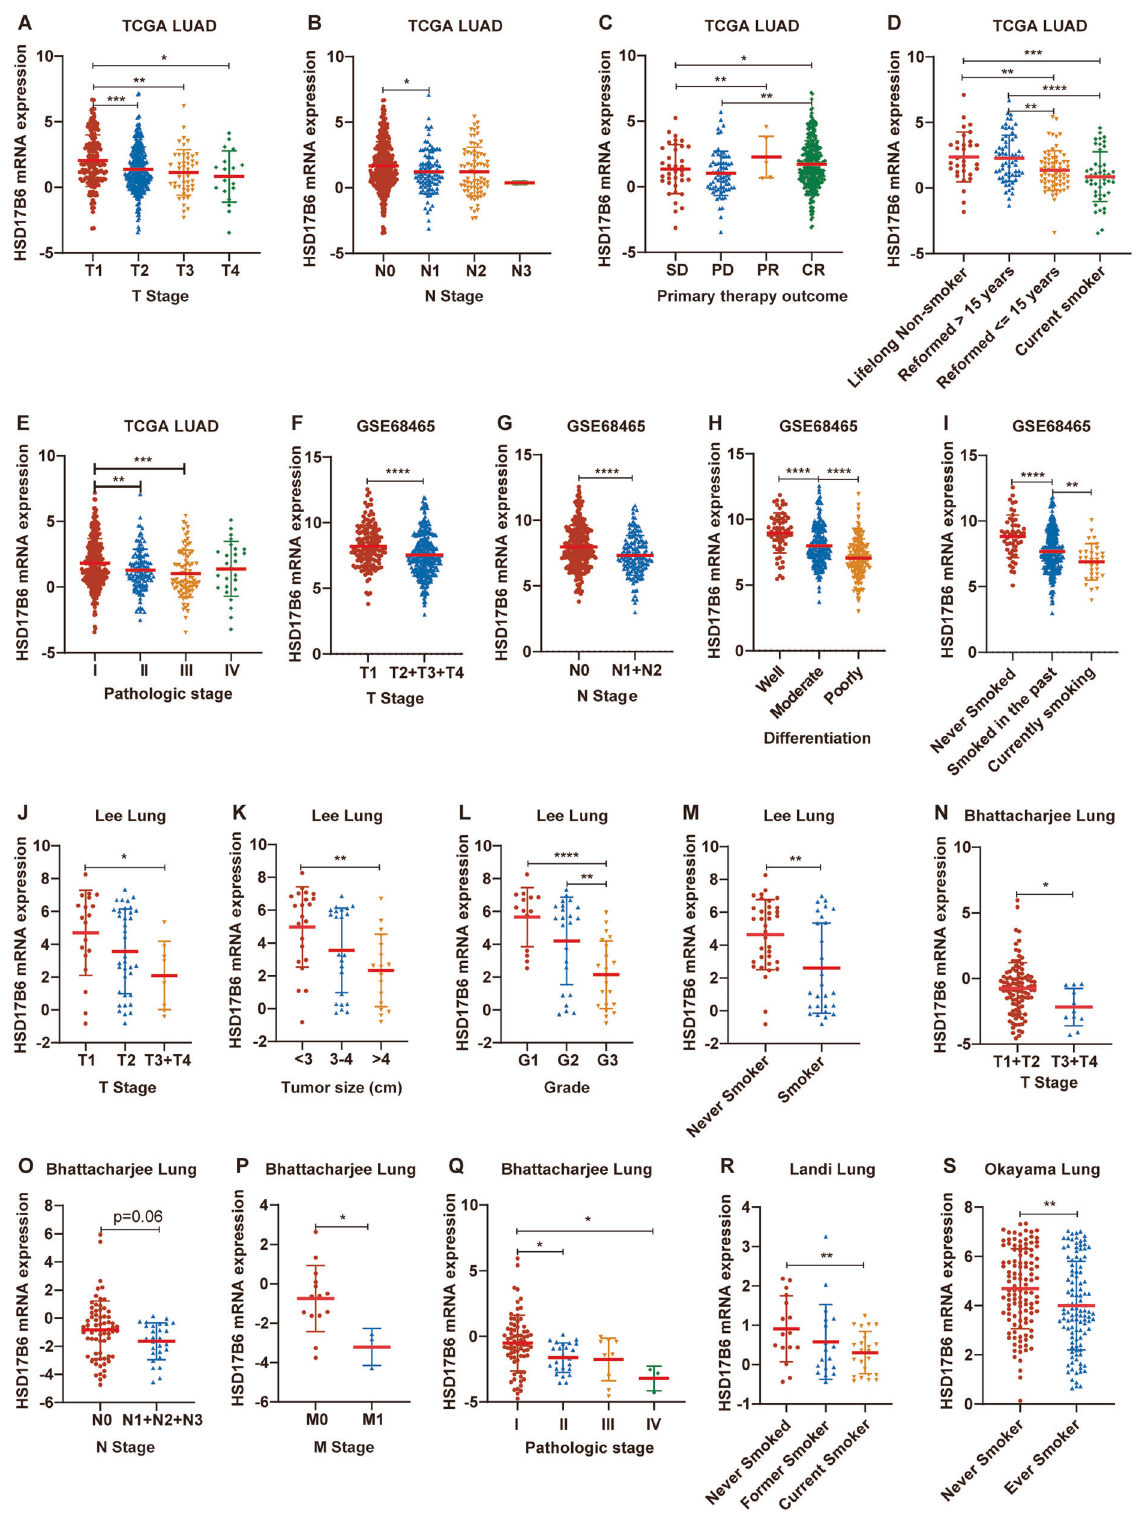
Fig. 2 HSD17B6 mRNA levels decrease with LUAD progression. A – E HSD17B6 mRNA levels in different T stages ( A ), N stages ( B ), primary therapy outcome ( C ), smoking status ( D ), and pathologic stages ( E ) of LUAD samples in TCGA LUAD dataset. F – I HSD17B6 mRNA levels in different T stages ( F ), N stages ( G ), tumor differentiation ( H ), and smoking status ( I ) of LUAD samples in GSE68465 dataset. J – M HSD17B6 mRNA levels in different T stages ( J ), tumor size ( K ), grade ( L ), and smoking status ( M ) of LUAD samples in “ Lee Lung ” dataset. N – Q HSD17B6 mRNA levels in different T stages ( N ), N stages ( O ), M stages ( P ), and pathological stages ( Q ) of LUAD samples in “ Bhattacharjee Lung ” dataset. R , S HSD17B6 mRNA levels in LUAD samples from patients with different smoking status in “ Landi lung ” ( R ) and “ Okayama lung ” ( S ) datasets. **** p < 0.0001, *** p < 0.001, ** p < 0.01, * p < 0.05.